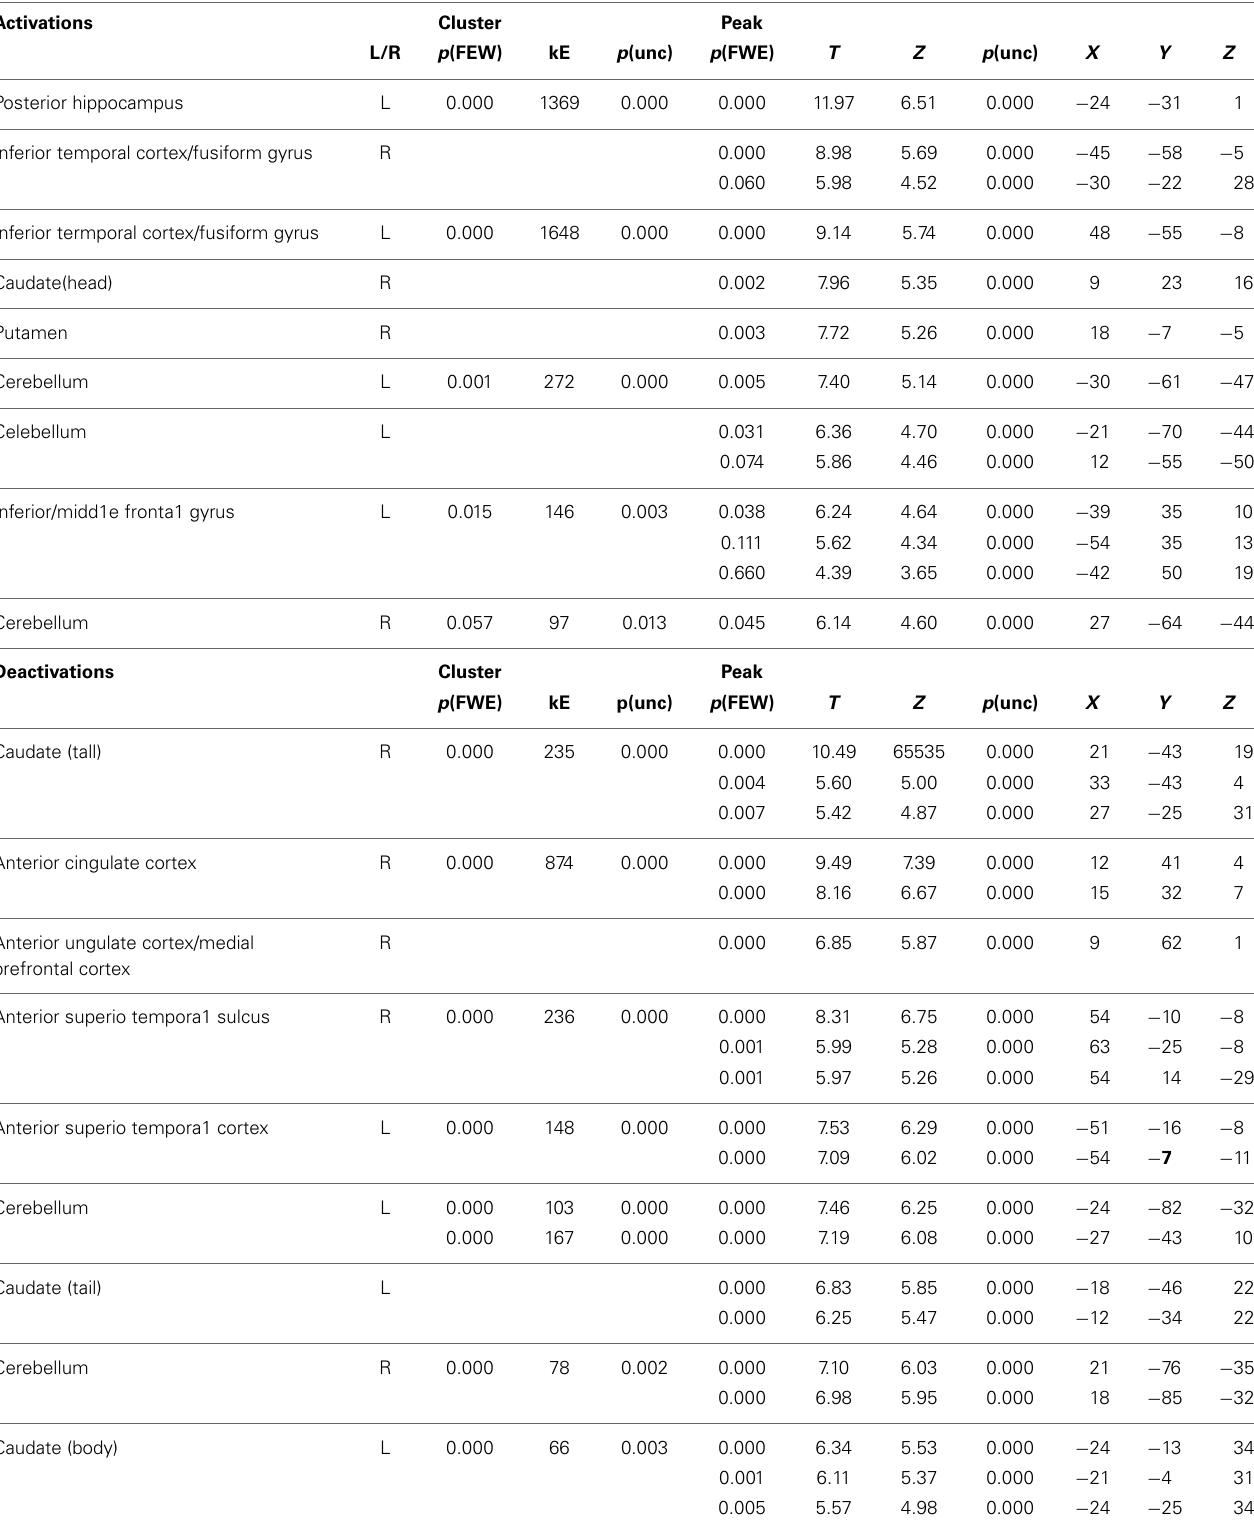
Table 2 | Location, MNI coordinates, cluster size and values for the activations produced by the parametric modulation with sublimity ratings and deactivations produced by the contrasts sublime <